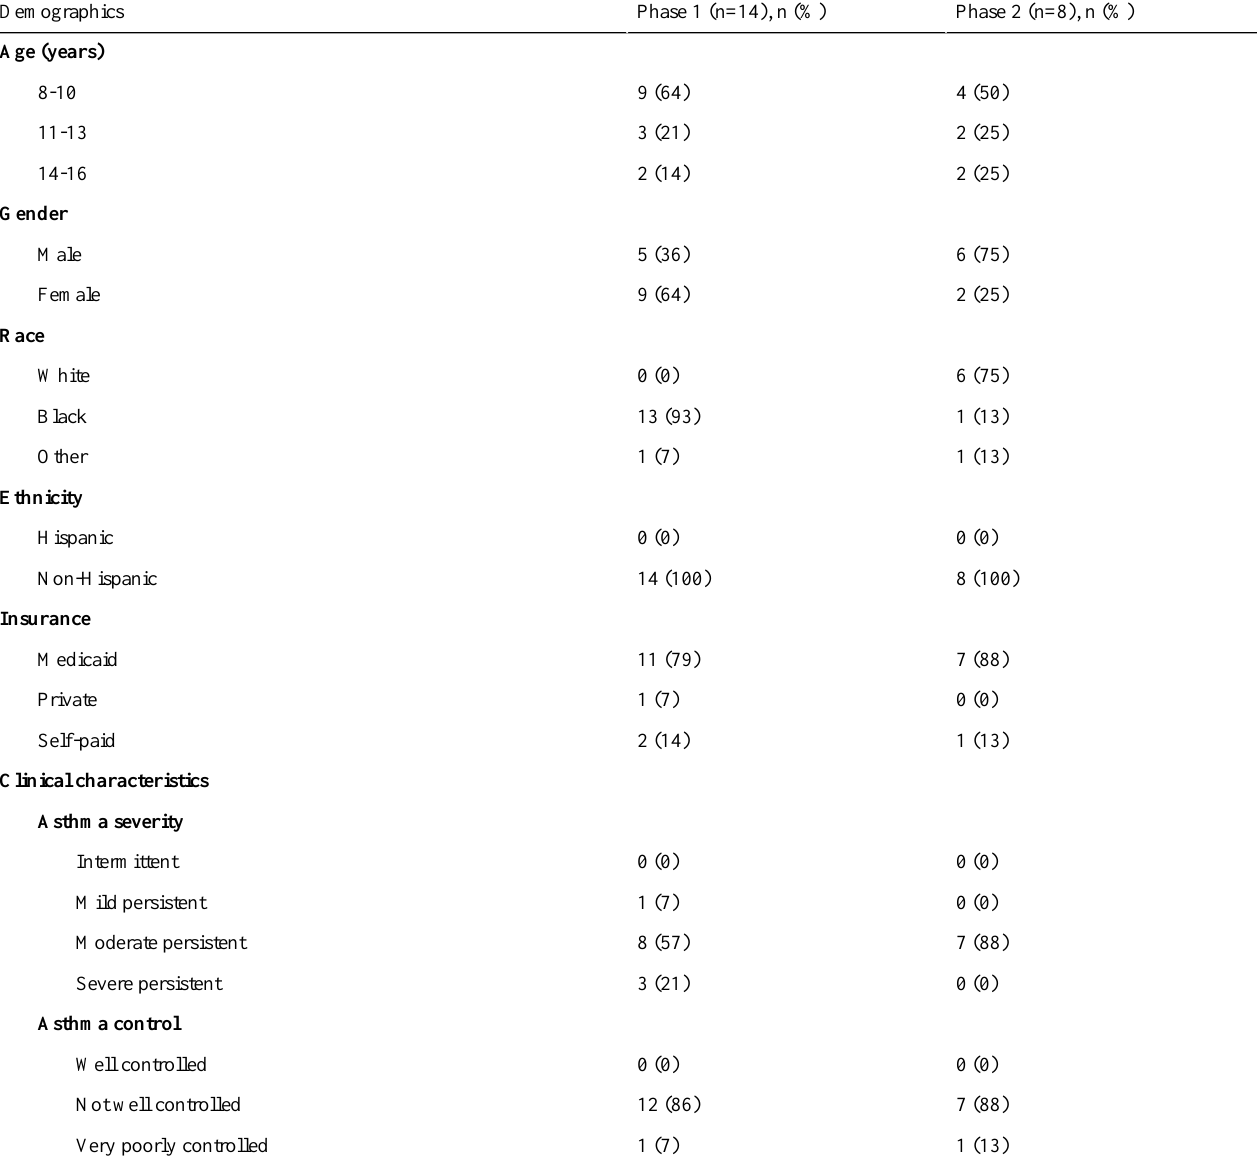
Table 2. Study population demographics by design phase.